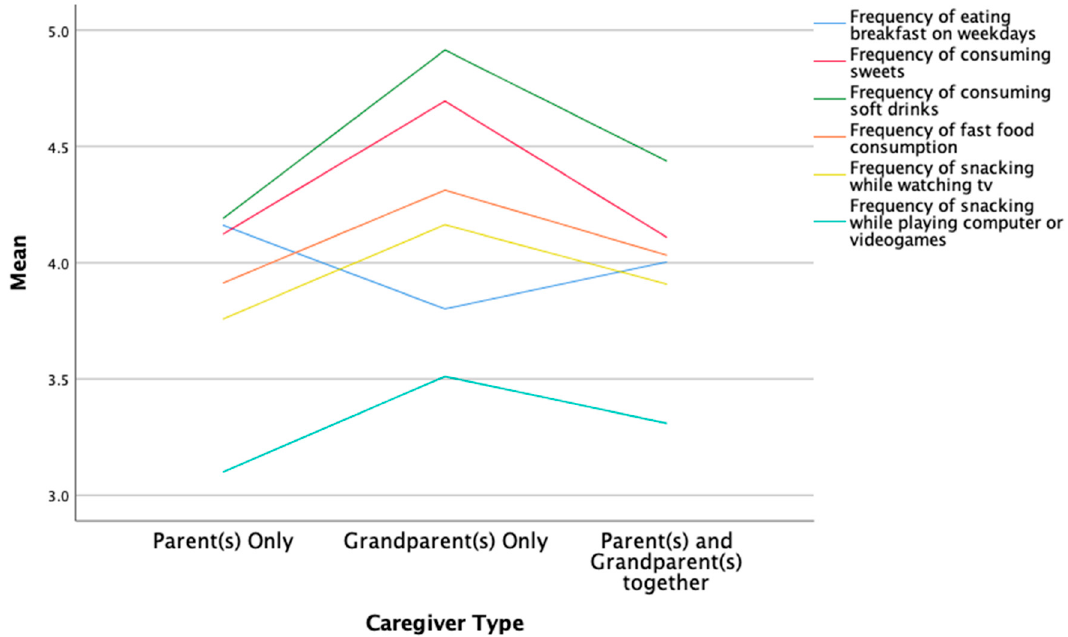
Figure 1. Significant group differences by caregiver type in the frequency of eating breakfast, nutri- tional intake, and snacking behavior.